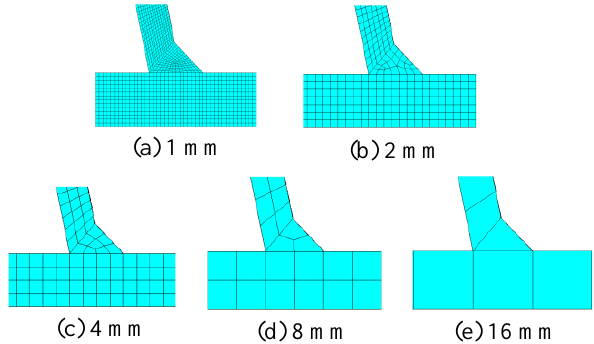
Figure 6. Mesh sizes of deck-rib welding details.